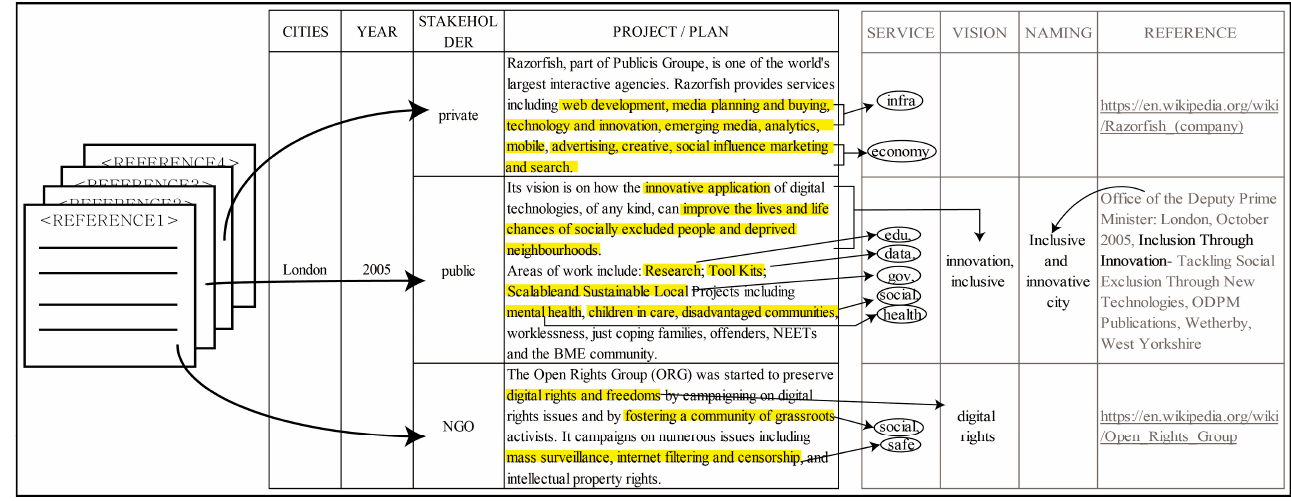
Figure 3. Compiling and Sorting